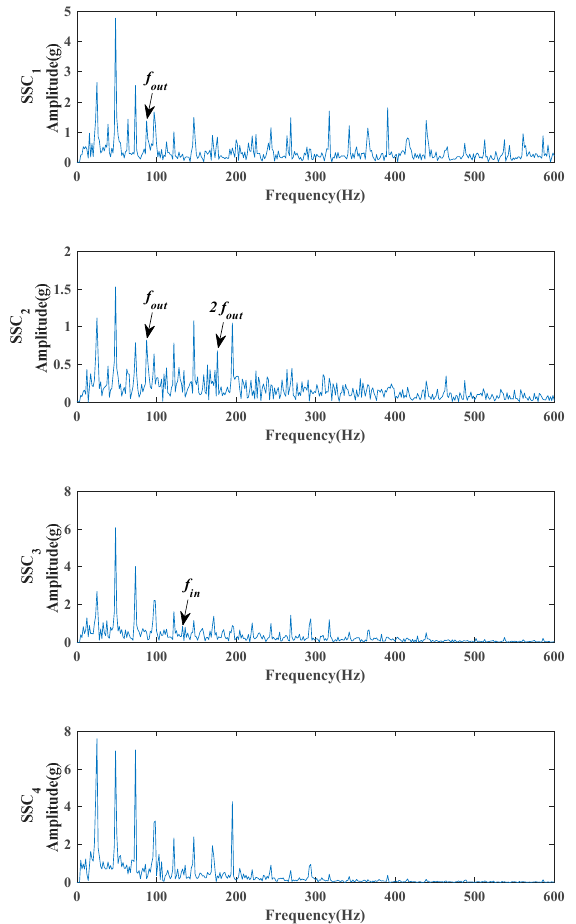
Figure 21. SSD decomposing results of the experimental compound fault signal. The SK kurtogram for the compound fault signal analysis is displayed in Figure 22a, based on which the optimal frequency band was confirmed in level 5. Then the optimal filter with a center frequency of 6133.33 Hz was created to get the filtered signal. The corresponding envelope spectrum of the filtered signal is shown in Figure 22b. Obviously, it was easy to identify the harmonics of the rotating frequency at 24.5 Hz, whereas the fault characteristic frequencies of 132.67 Hz and 87.83 Hz could not be detected. Therefore, for the composite fault signals, the acquired sensitive component using the IMACMD method could better separate the sensitive components and more effectively obtain the fault characteristics information than the SSD and SK methods.